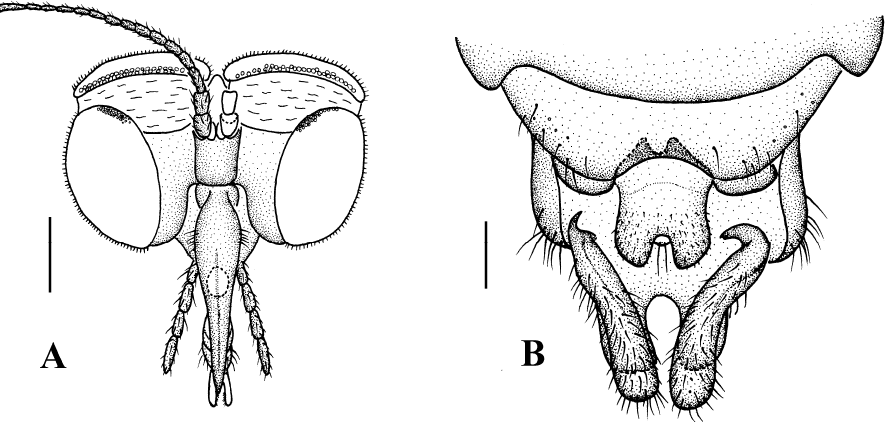
Figure 10. Blepharicera nigra sp. nov. (female paratype). ( A ) female head, frontal view ( B ) female terminalia, ventral view. Scale bars: 0.25 mm ( A ), 0.10 mm ( B ). Distribution. Currently known only from China